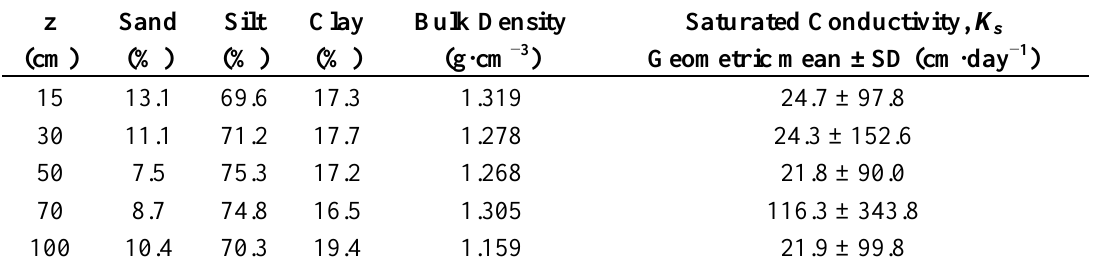
Table 2. Measured particle distribution, bulk density, and hydraulic conductivity of all layers.